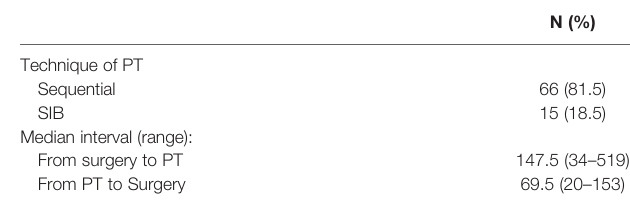
TABLE 1 | Patient Demographics, Tumor and Treatment